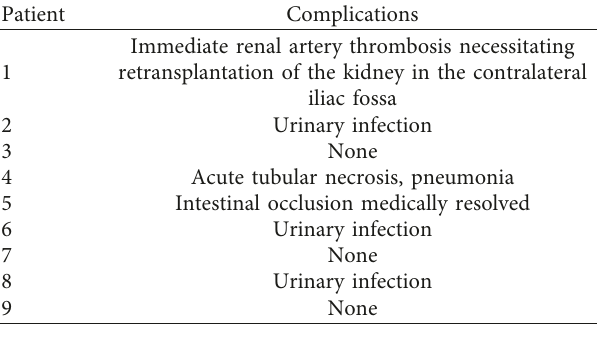
Table 3: Perioperative and postoperative